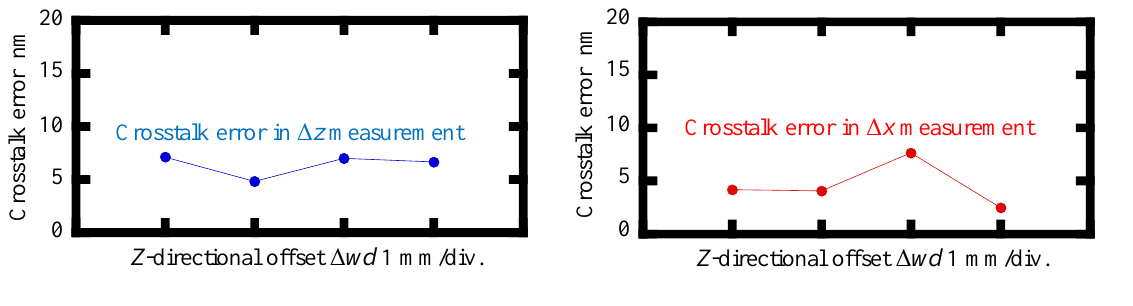
Z -directional offset Δ wd 1 mm/div. Figure 13. Variations in amplitudes of the crosstalk errors when the Z - directional offset Δ wd was Figure 13. Variations in amplitudes of the crosstalk errors when the Z -directional offset ∆ wd was applied to the scale grating: ( a ) Readout of Δ z when X -axis displacement was applied to the scale Figure 13. Variations in amplitudes of the crosstalk errors when the Z - directional offset Δ wd was applied to the scale grating: ( a ) Readout of ∆ z when X -axis displacement was applied to the scale grating; ( b ) Readout of Δ x when Z -axis displacement was applied to the scale grating. applied to the scale grating: ( a ) Readout of Δ z when X -axis displacement was applied to the scale Figure 13. Variations in amplitudes of the crosstalk errors when the Z - directional offset Δ wd was grating; ( b ) Readout of ∆ x when Z -axis displacement was applied to the scale grating; ( b ) Readout of Δ x when Z -axis displacement was applied to the scale grating. applied to the scale grating: ( a ) Readout of Δ z when X -axis displacement was applied to the scale grating; ( b ) Readout of Δ x when Z -axis displacement was applied to the scale grating.